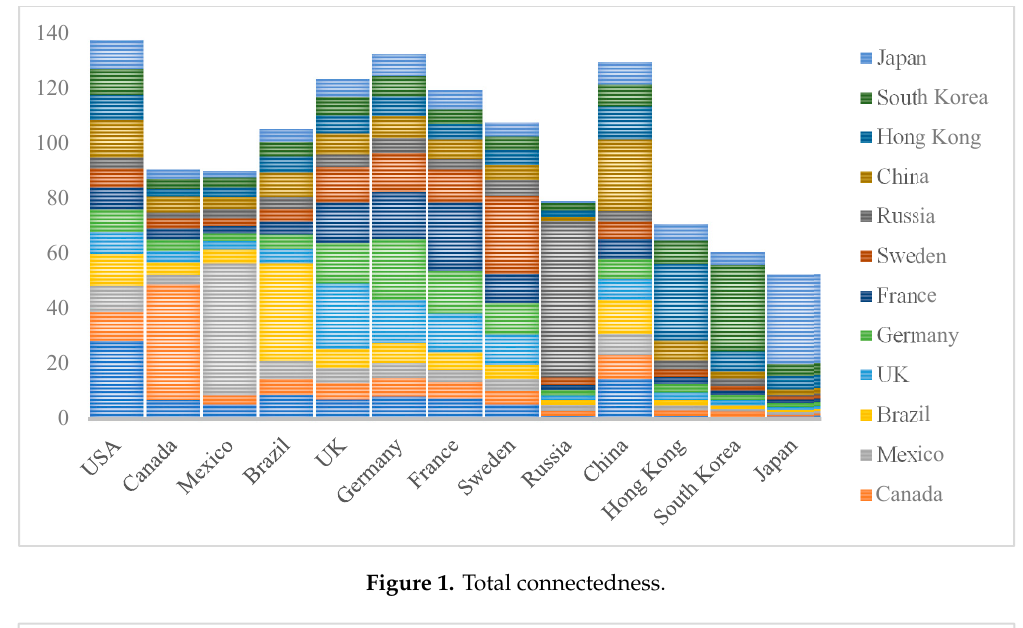
Figure 1. Total connectedness.